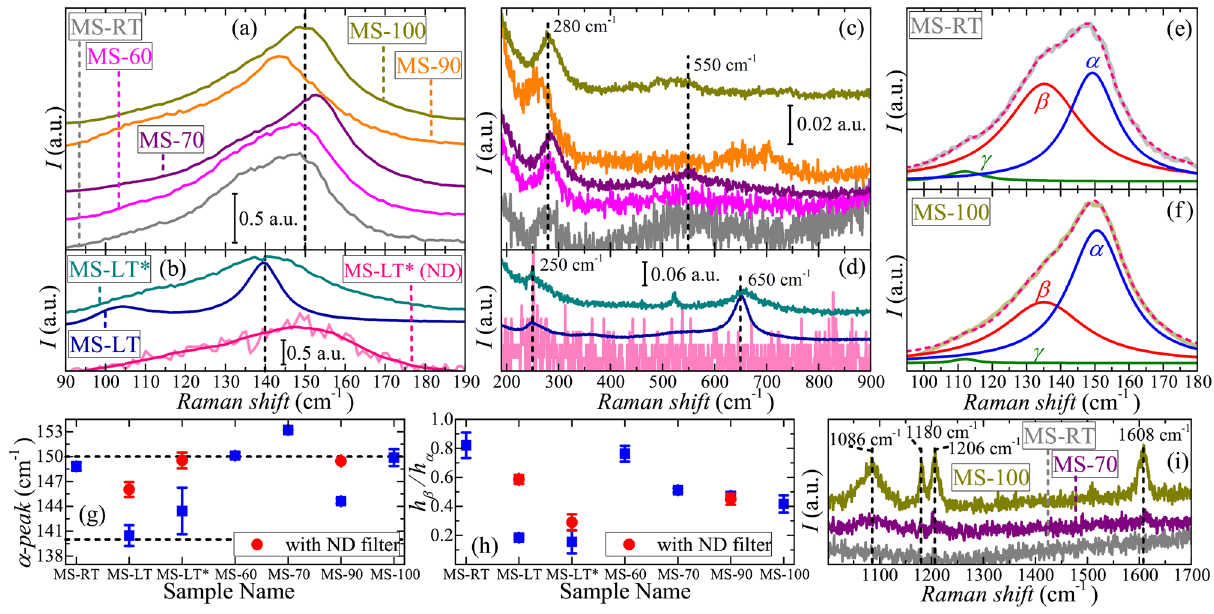
Figure 4. ( a – d ) Raman spectra of studied films measured at room temperature, curves are vertically shifted for clarity. Experimental curves in ( a ) and ( c ), ( b ) and ( d ) panels are shown in the same order. Spectra of MS-LT* sample, showed by pink color in ( b ) and ( d ), was recorded using ND filter. Deconvolution of main peak for samples ( e ) MS-RT and ( f ) MS-100, obtained cumulative curves are shown by dashed lines. ( g ) α -peak position and ( h ) ratio of β - and α -peaks heights for studied films averaged over several spectra, obtained from different areas of the sample. The results obtained for spectra measured using ND filter are shown by red circles. ( i ) High- frequency parts of Raman spectra for samples MS-RT, MS-70 and MS-100. Black dashed lines in panels ( a – d ) and ( i ) show characteristic peak positions in provided experimental